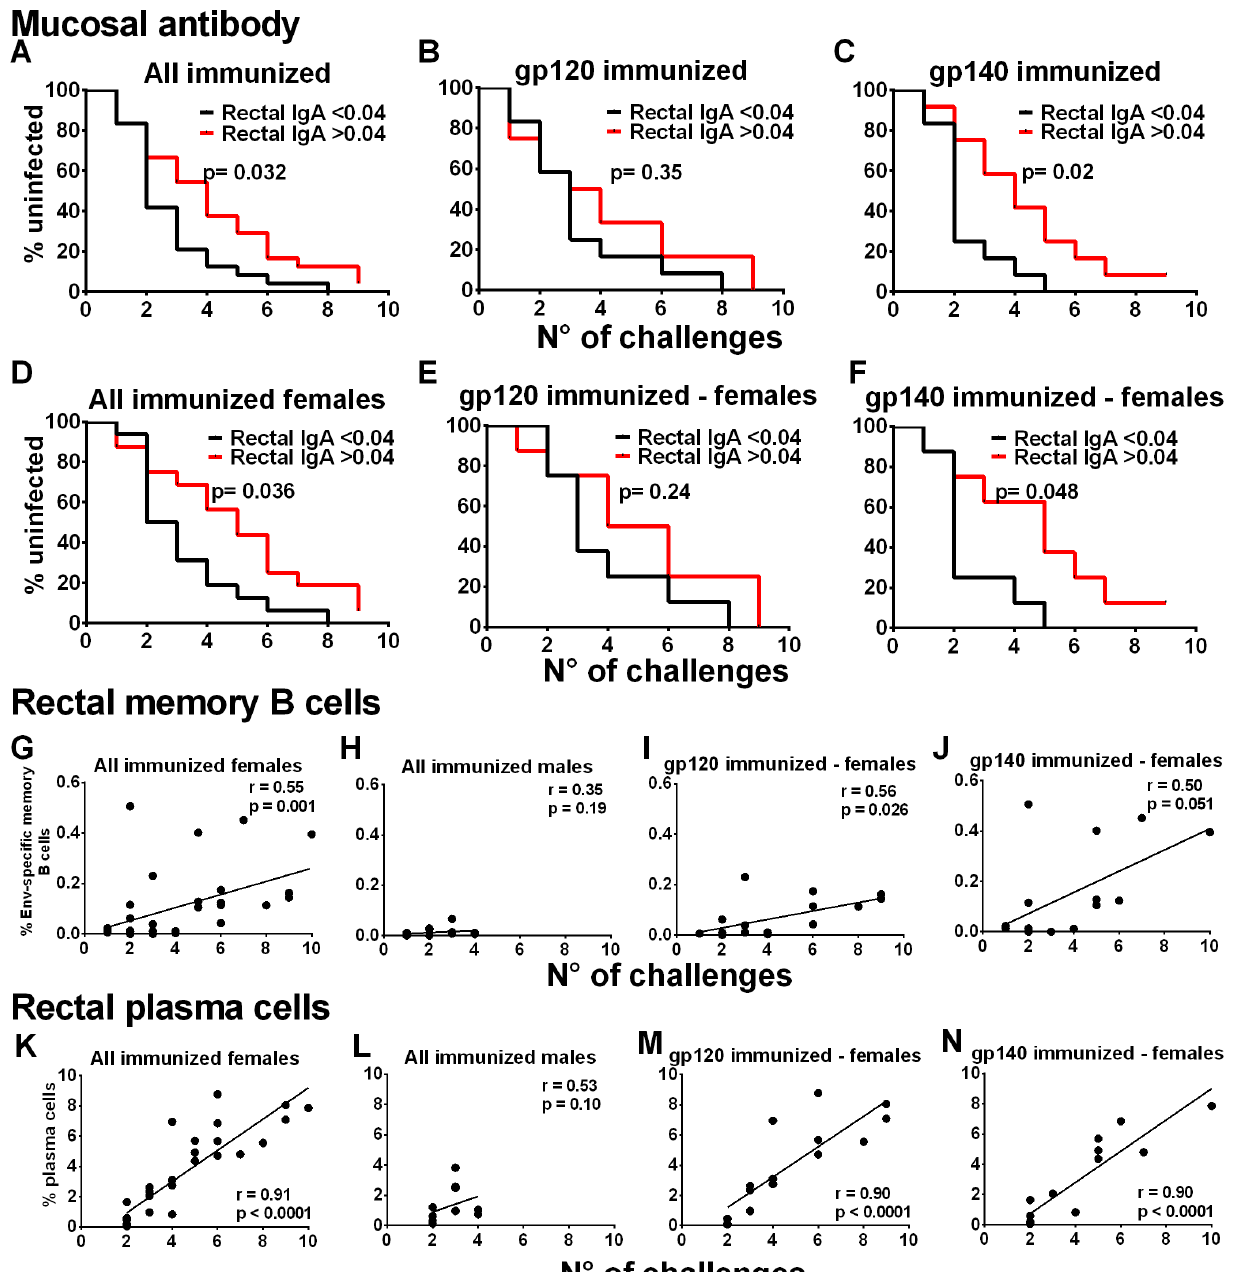
Fig 3. Immunological correlates of delayed SIV acquisition. Influence of rectal Env-specific IgA at wk 55 on the rate of infection in (A) all immunized macaques, (B) in gp120 immunized macaques, and (C) in gp140 immunized macaques. Influence of rectal Env-specific IgA at wk 55 on the rate of infection in (D) all immunized females, (E) in gp120-immunized females, and (F) in gp140-immunized females. gp120 and gp140-immunized macaques were tested against gp120 and gp140 proteins respectively. Control background levels were subtracted prior to analysis. Correlation analysis of Env-specific memory B cells in rectal tissue identified by flow cytometry 2wkpi with number of challenges to become infected in (G) all immunized females, (H) all immunized males, (I) gp120-immunized females, and (J) gp140-immunized females. Correlation analysis of rectal plasma cells identified by flow cytometry 2wkpi with number of challenges to become infected in (K) all immunized females, (L) all immunized males, (M) gp120-immunized females, and (N) gp140-immunized females. One gp140-immunized female remained uninfected and is excluded from the 2wkpi time point in panels G, J, K, and N. In panels K-N, PC were identified following the first challenge using IRF-4 and BCL2 intracellular markers. Subsequently, all data were obtained using the surface marker CD138 and IRF-4. As the two approaches are not comparable, the week one challenge data are